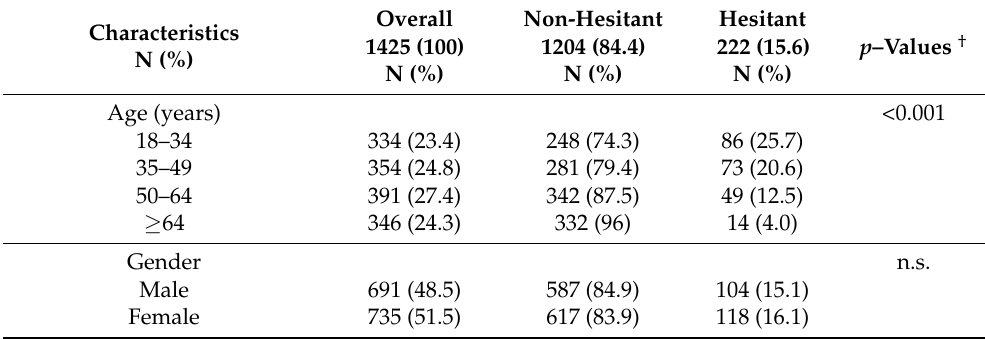
Table 1. Characteristics of the sample and comparison between non-hesitant and hesitant